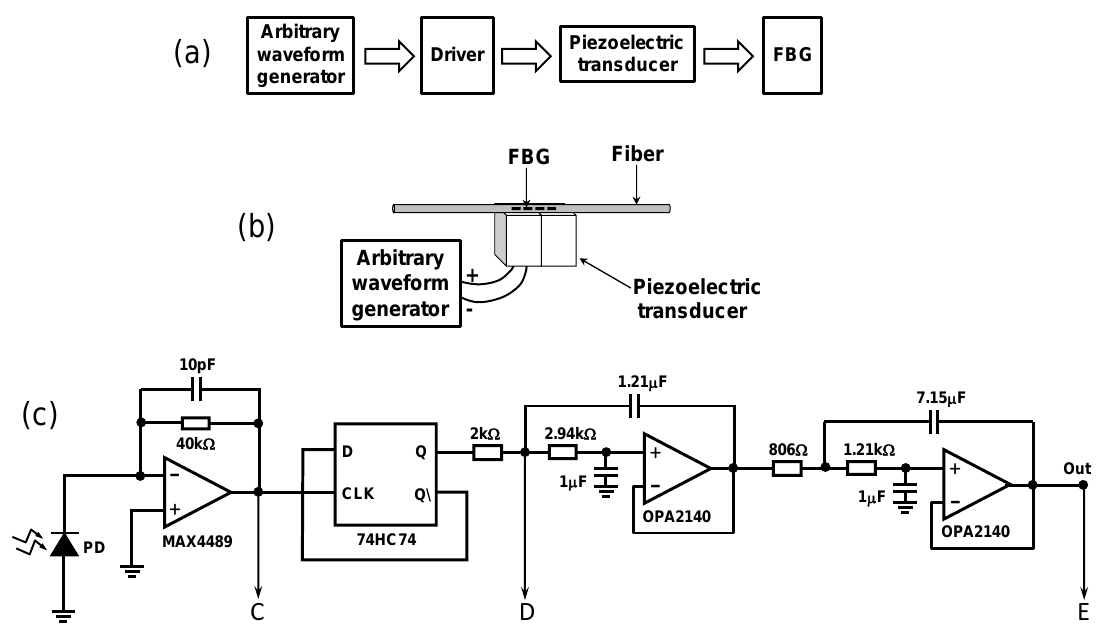
Figure 3. ( a ) Scheme to simulate the temperature changes and dynamical pressures on FBG, ( b ) FBG coupled to a PZT, and ( c ) electronic circuit of the demodulator.